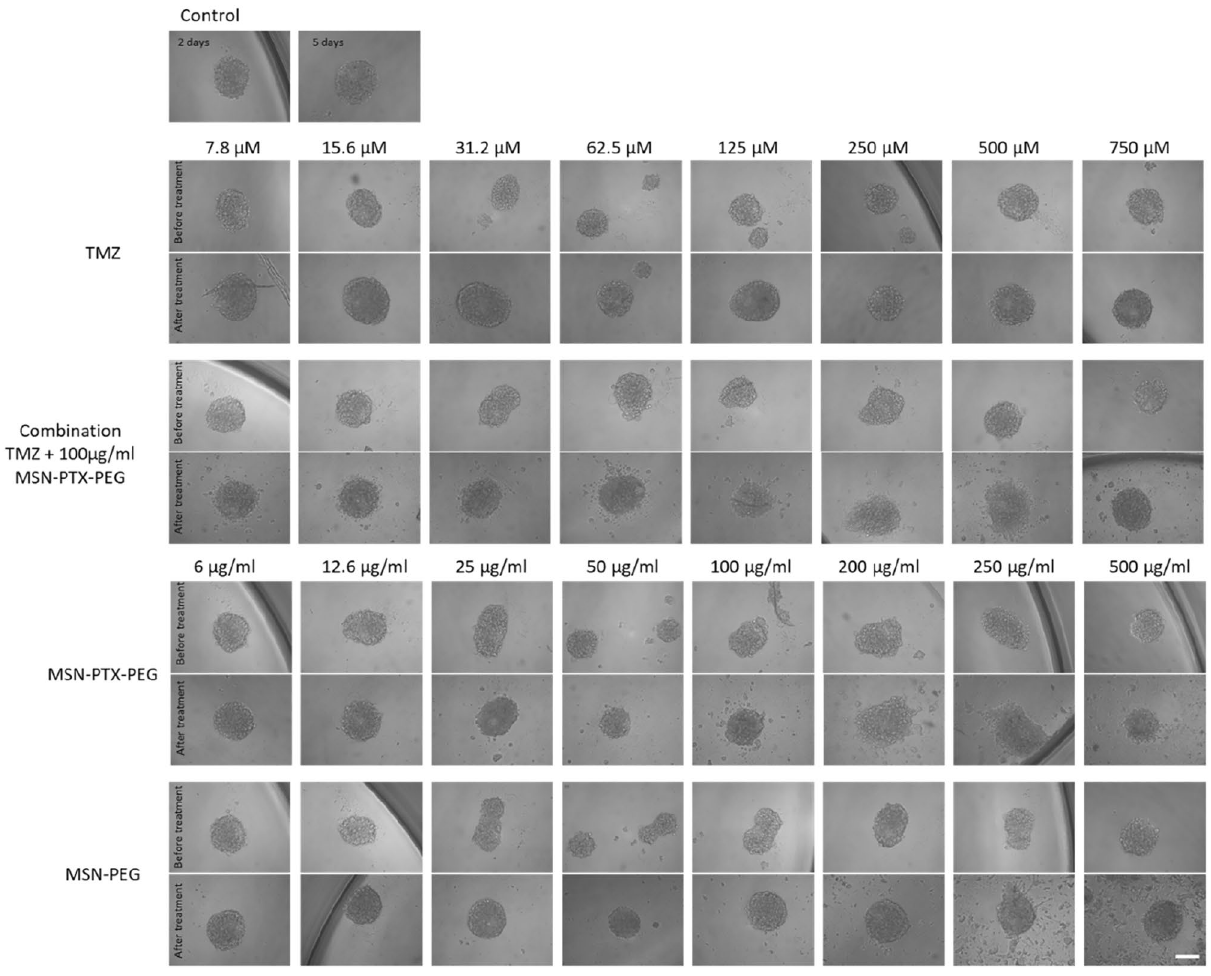
Figure 10. Representative images of U-87 GBM spheroids grown for 2 days and either untreated (upper panels) or treated for 72 h (lower panels) with TMZ, TMZ combined with 100 µg/ml MSN-PTX-PEG, MSN-PTX-PEG and MSN-PEG. Images are representative of three independent experiments (scale bar 200